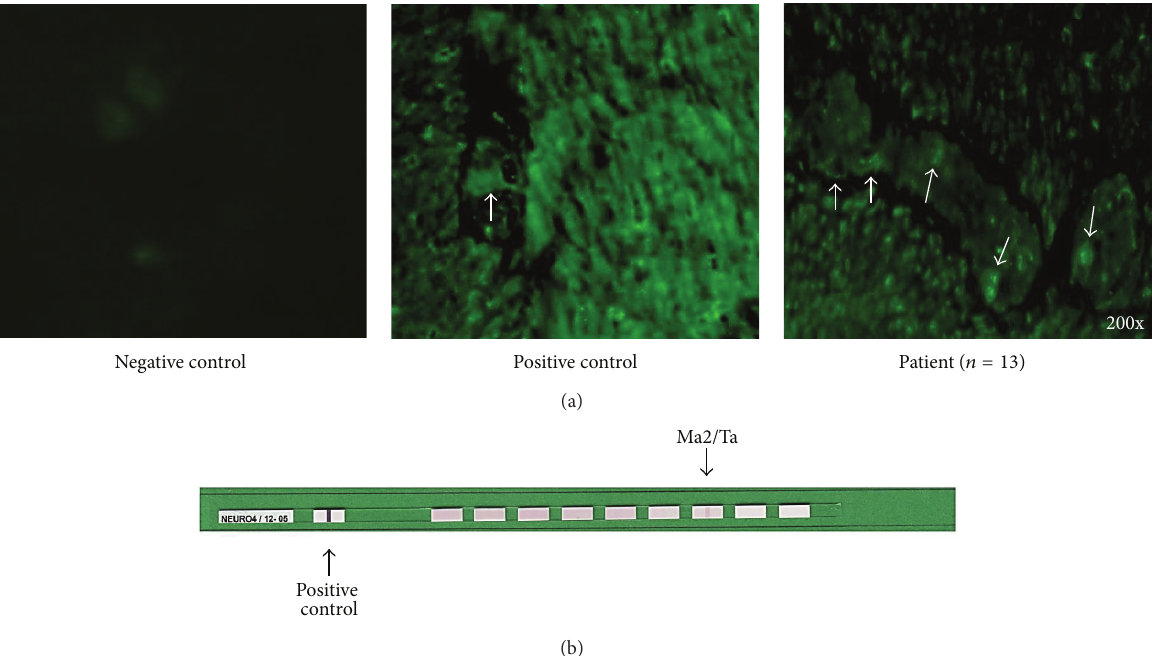
Figure 6: Anti-myenteric plexus antibodies and antigenicity. (a) Indirect immunofluorescence of monkey intestinal tissue containing Auerbach’s plexus. Arrows show positive fluorescent nuclei and cytoplasm of cells that were recognized by circulating anti-myenteric plexus autoantibodies from achalasia patients (right panel). (b) Profile of neuronal antigens (antigens on membrane strips). Arrow in upper strip shows circulating autoantibodies against PNMA2 (Ma2/Ta) antigen. Arrow in lower strip shows circulating antibodies against recoverin